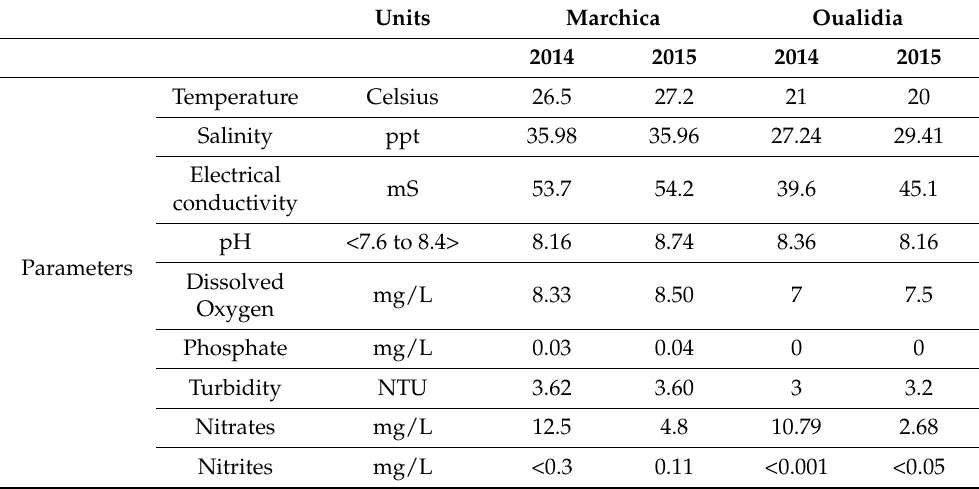
Table 1. Physical and chemical data measured in waters of Marchica and Oualidia lagoons at the time of